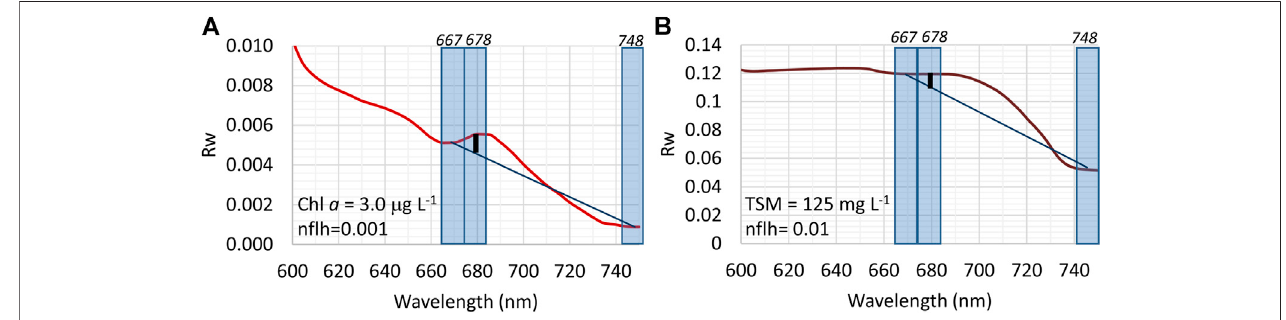
FIGURE 3 | Narrowband features like chlorophyll fl uorescence can be inaccurately estimated when using multi-spectral bands that are distant from the feature, such as the blue bands used in the normalized fl uorescence line height (n fl h). Examples of (A) water-leaving Re fl ectance (Rw) spectrum with a typical chlorophyll fl uorescence feature and (B) a spectrum representative of high sediment water with no observable chlorophyll fl uorescence leads to an erroneously high n fl